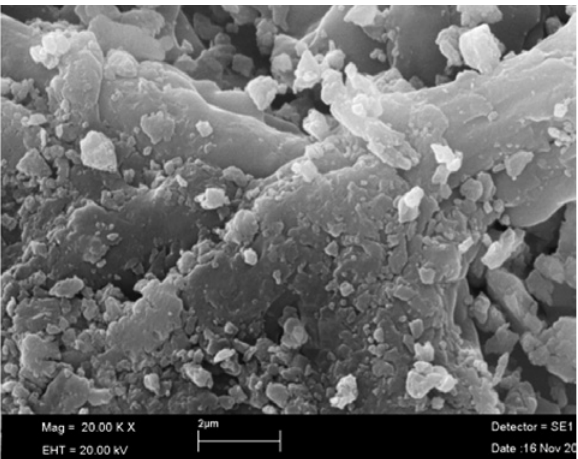
Fig. 1. SEM micrograph of waste eggshell